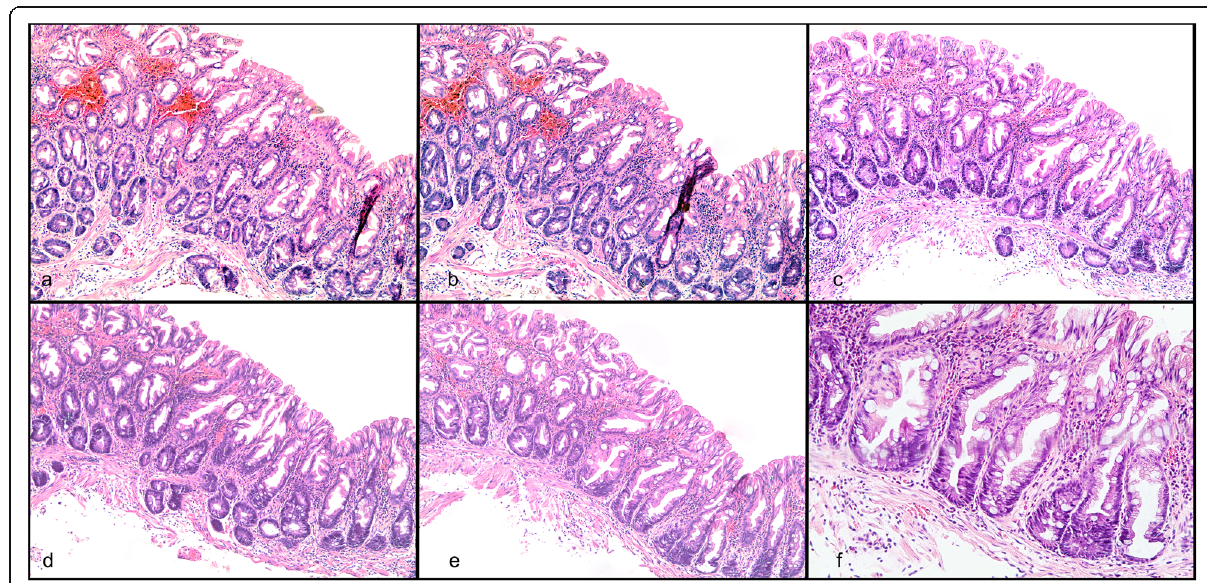
Fig. 2 H&E stain of HP reclassified as SSL. × 100 first ( a ) and fourth ( b ) of five sections of original slides showing features of hyperplastic polyp,